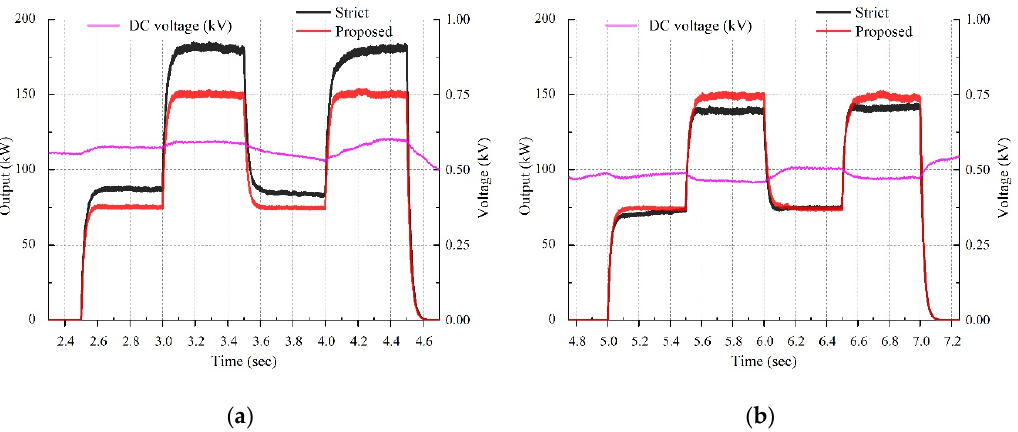
Figure 12. Detailed power compensation quantities for ESS with DC voltage variations ( a ) extracted power quantity in the discharging section (2.5 to 4.5 s); ( b ) absorbed power quantity in the charging section (5 to 7 s).